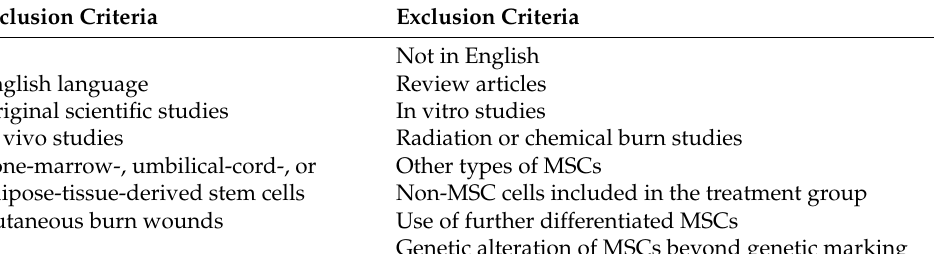
Table 1. Inclusion and exclusion criteria.